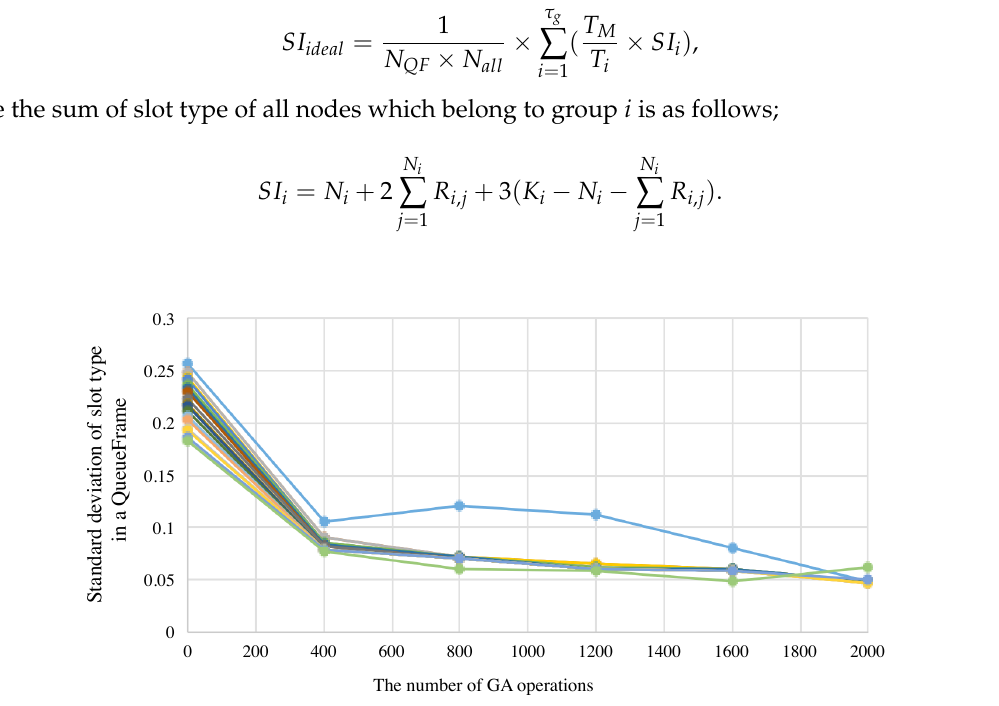
Figure 11. Transition of standard deviation slot type value of the top 20 individuals, where N all = 10.